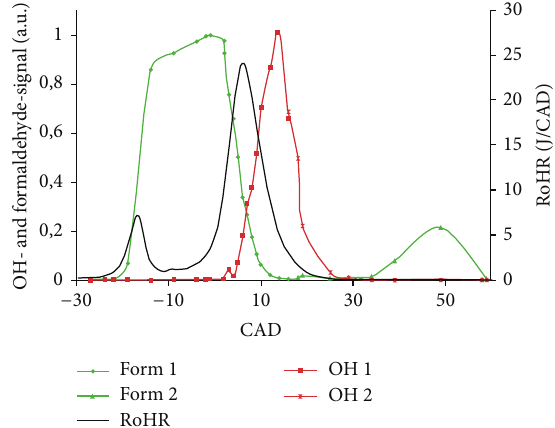
Figure 16: Average rate of heat-release and average OH- and HCHO-signals